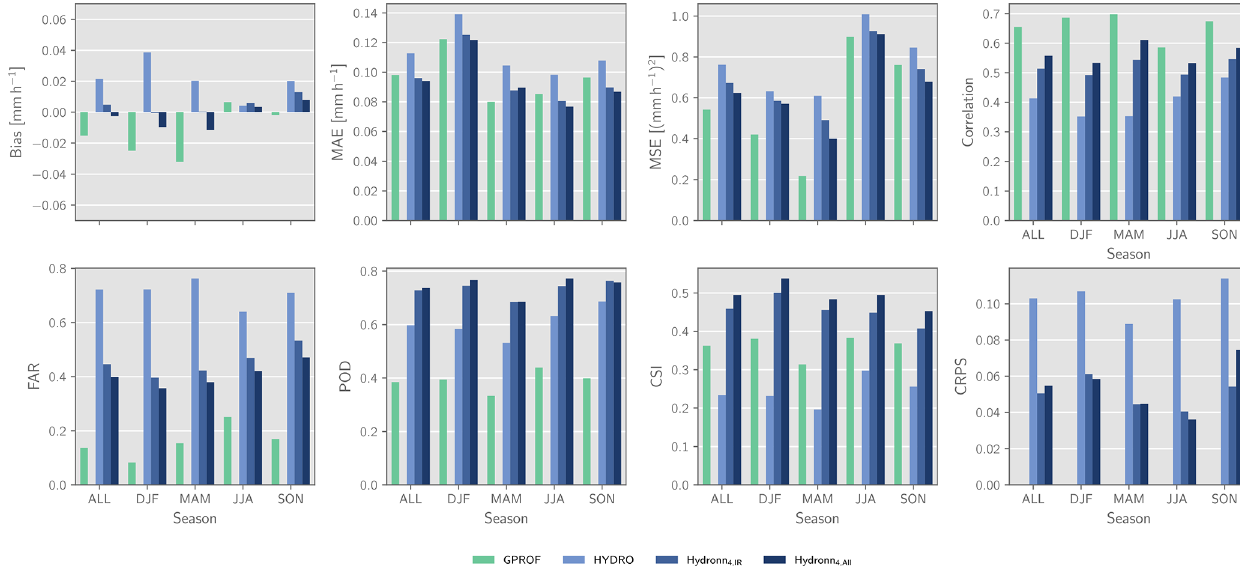
Figure 10. Retrieval accuracy with respect to GPM CMB for overpasses on days 1, 6, 11, 16, 21, and 26 of each month of 2020 over the domain R2. Each panel shows the average of a metric over the full year as well as its seasonal